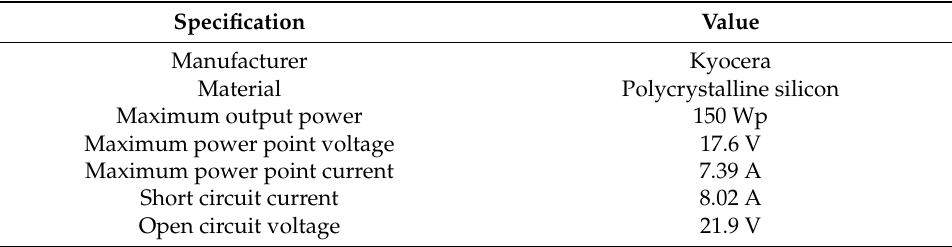
Table 2. Specifications of the PV panels under